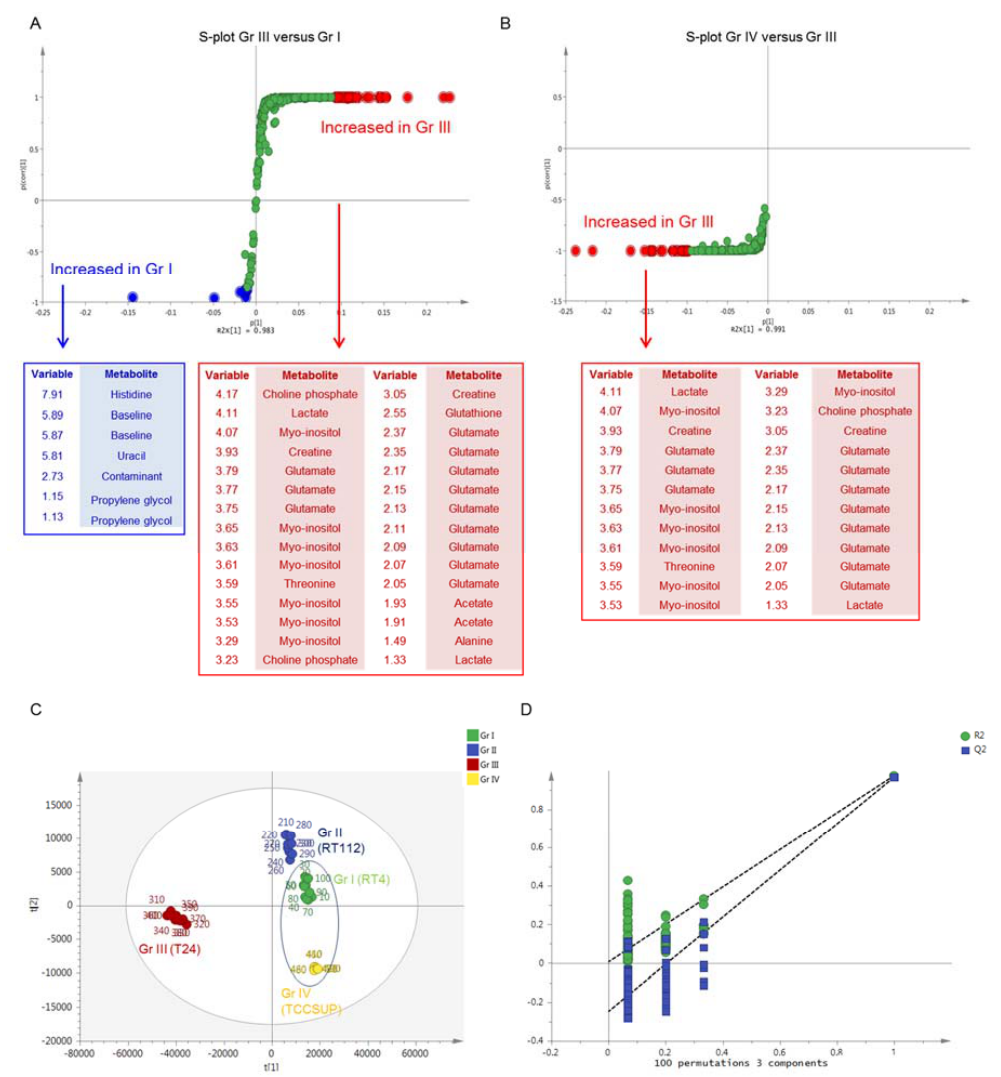
Figure 3. Multivariate analysis of 1 H NMR spectra of the four UBC cell lines. ( A ) S-plot of Orthogonal Partial Least Square-Discriminant Analysis (OPLS-DA) model of grade I (RT4) versus grade III (T24) cell line and the respective loadings. Red dots: increased in grade III (T24), Blue dots: increased in grade I (RT4). ( B ) S-plot of OPLS-DA model of grade III (T24) versus grade IV (TCCSUP) cell line and the respective loadings. Red dots: increased in grade III (T24). ( C ) Scores plot of Partial Least Square-Discriminant Analysis (PLS-DA) model of the four UBC cell lines. Grade I (RT4) and grade IV (TCCSUP) groups seem unable to be discriminated, among each other, on the first principal component, while the grade III (T24) group is the most distant from the initial conditions on the same component. ( D ) Permutation test of the PLS-DA model of the four UBC cell lines. Gr: (malignancy)